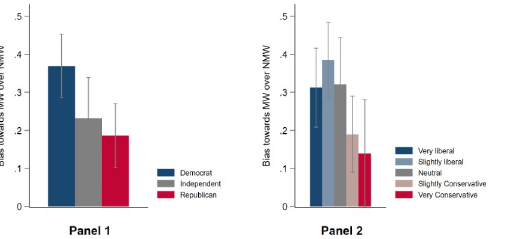
Fig 4. Bias towards Mask Wearers (MW) over Non-Mask Wearers (NMW) by political affiliation. Bias is calculated as the difference in average cooperation levels toward mask wearers (MW) and non-mask wearers (NMW) in the simultaneous PD games. 4-standard-error bars (2 above, 2 below) to represent 95% confidence intervals. points ( p = 0.015) lower than Democrats’. When facing a non-mask-wearing partner, Indepen- dents’ and Republicans’ cooperation rates were instead both 8 percentage points ( p = 0.151 and p = 0.109 respectively) higher than Democrats’. The lower cooperation rates towards mask wearers compared to non-mask wearers of 13 percentage points for Independents and 18 per- centage points for Republicans are statistically significant in t -tests, p = 0.058, and p = 0.002. Similar results also hold for the interaction between a mask-wearing partner and political con- servativeness, see S7 Table, Panel B.